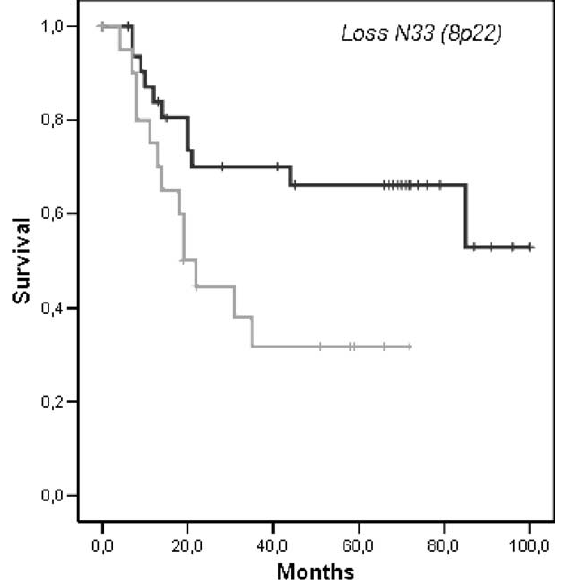
Fig. 4. Kaplan–Meier survival curve of loss of gene N33 detected by MLPA in 56 larynx and pharynx squamous cell carcinomas ( p = 0 . 02). The black line represents cases without loss of N33 and the gray line cases with loss of N33